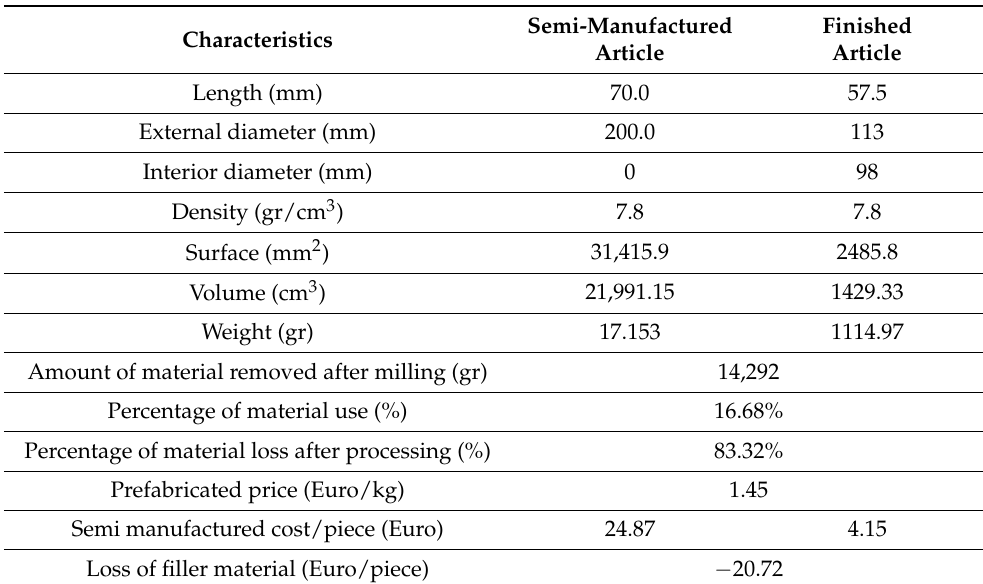
Table 5. Raw material cost and percentage material use for component construction using conven- tional CNC